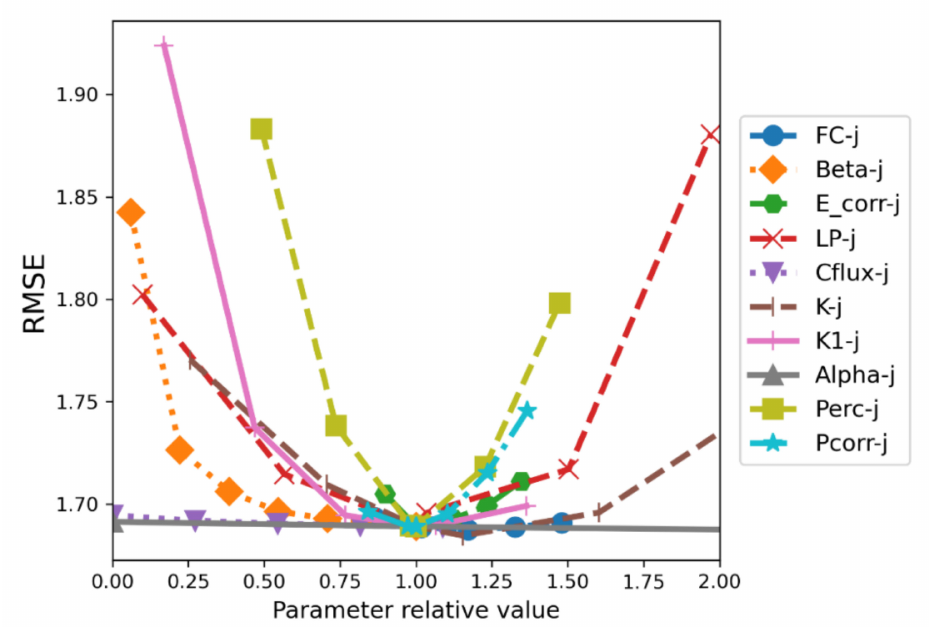
Figure 8. OAT sensitivity analysis with RMSE as evaluation criteria; the relative values of parameters are plotted in one